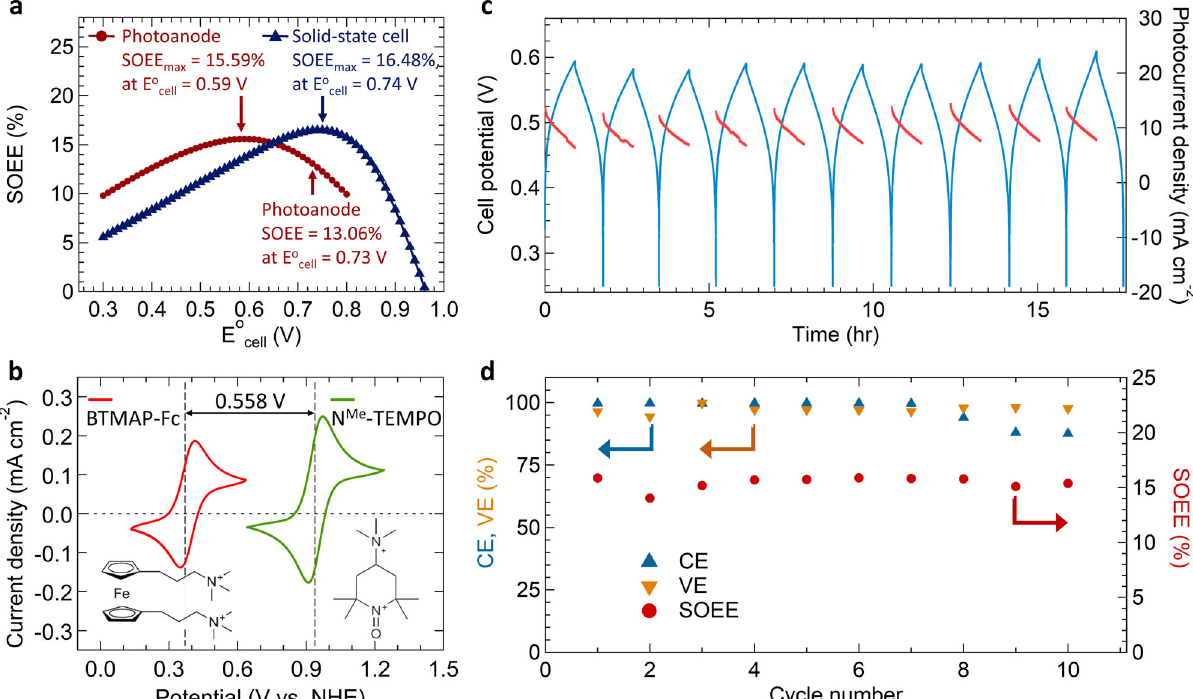
Fig. 5 The potential matching simulation and the characteristics of SFB cycling. An improved SFB with SJ-GaAs photoanode and BTMAP-Fc/N Me - TEMPO redox couples. a The numerically calculated SOEE as a function of E 0 by using the LSV data from the SJ-GaAs photoelectrode (red curve was cell simulated by the data from Fig. 3a) and solid-state SJ-GaAs cell (blue curve was simulated by the data from Fig. 1d). b The cyclic voltammograms of 5.0 mM BTMAP-Fc (red curve) and 5.0 mM N Me -TEMPO (green curve) collected at a scanned rate of 10 mV s − 1 on a glassy carbon electrode in 1.0 M NaCl supporting electrolyte. c Cell potential (blue) and photocurrent density (red) vs. time of the integrated SFB device during cycling. d CE (blue triangles), VE (orange triangles) and SOEE (red circles) of the integrated SFB device over 10 cycles. The SFB cycling was performed with 0.1 M BTMAP-Fc/N Me -TEMPO redox couples in catholyte/anolyte and a fl ow rate of 60 mL min − 1 over 10 cycles under one Sun solar illumination. Each cycle started with 36 min of bias- free solar charging process followed by a galvanostatic discharging step at 11 mA until reaching the cutoff potential (0.25 V). NATURE COMMUNICATIONS| (2021) 12:156